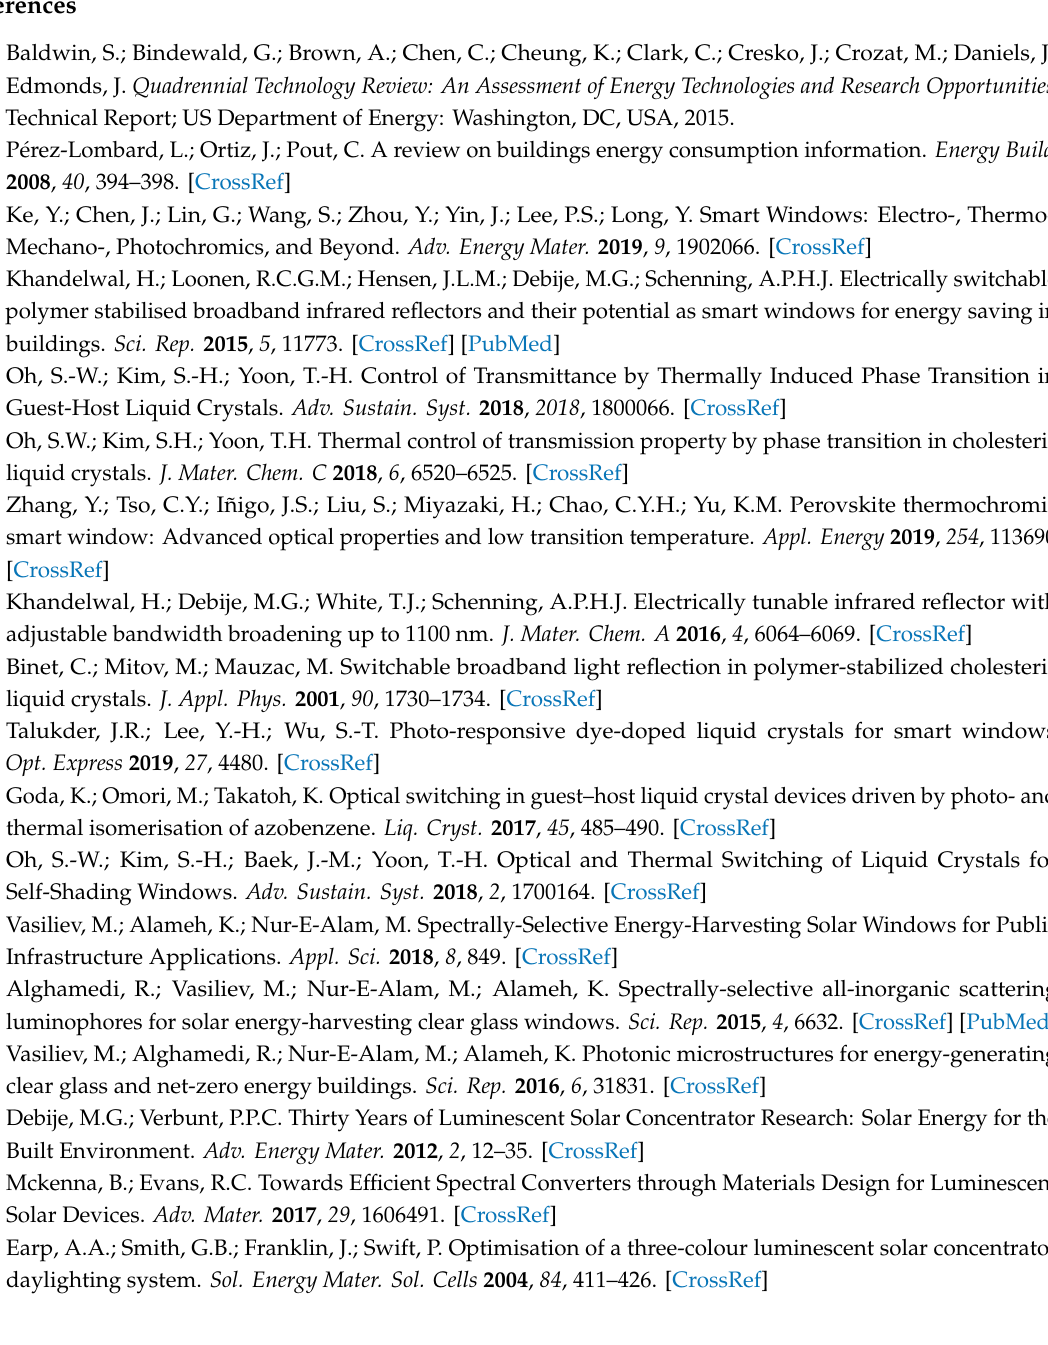
Figure S1: Di ff erential scanning calorimetry of the dye doped 8CB cells; Figure S2: Polarized optical microscopy images of a LC